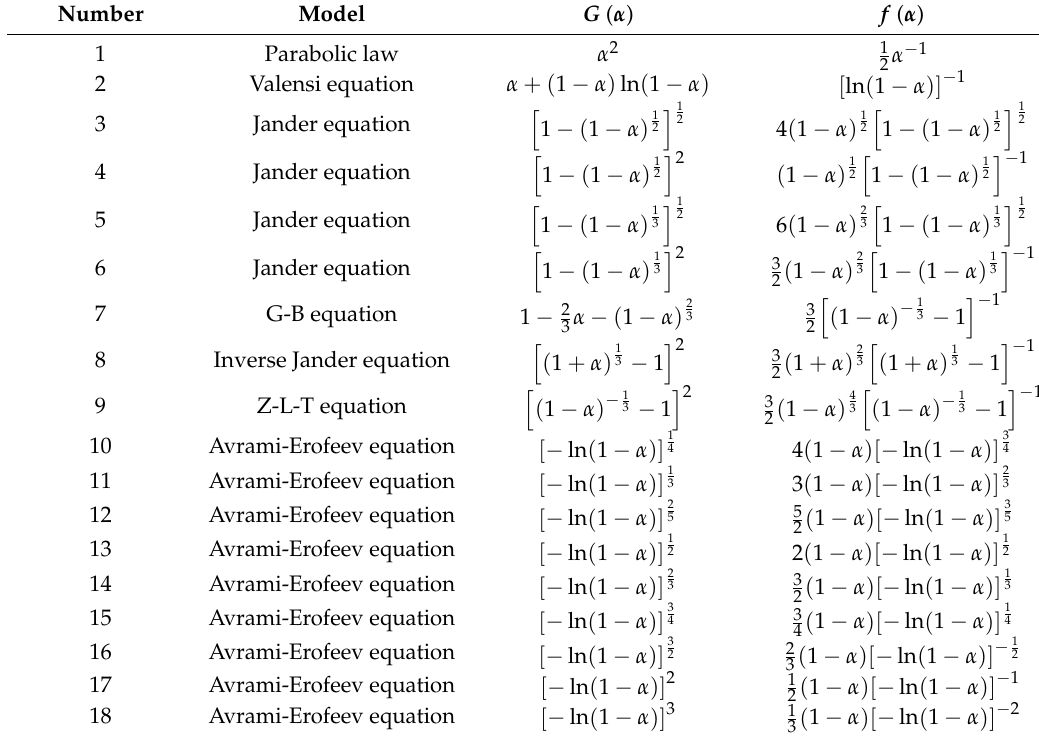
Table 2. Common mechanism functions and corresponding f ( α ) and G ( α